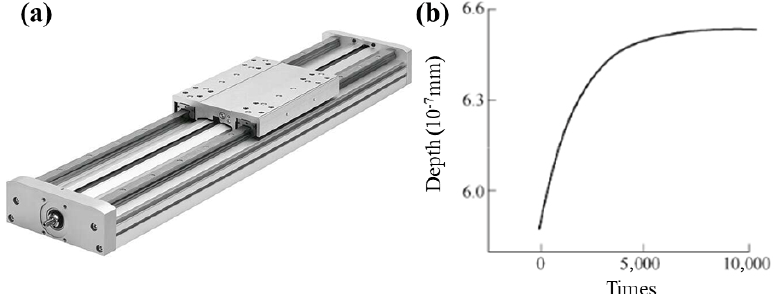
Fig. 13 Regular law of wear and tear of linear motion guideway. (a) Machine linear motion guideway, (b) changing trend of the single wear depth of the edge node of the guideway with the number of wear. Reproduced with permission from Ref. [152], © China Academic Journal Electronic Publishing House